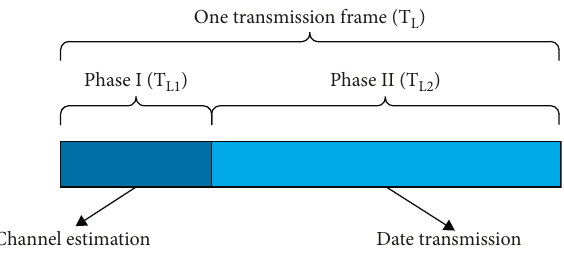
Figure 2: Transmission mode.